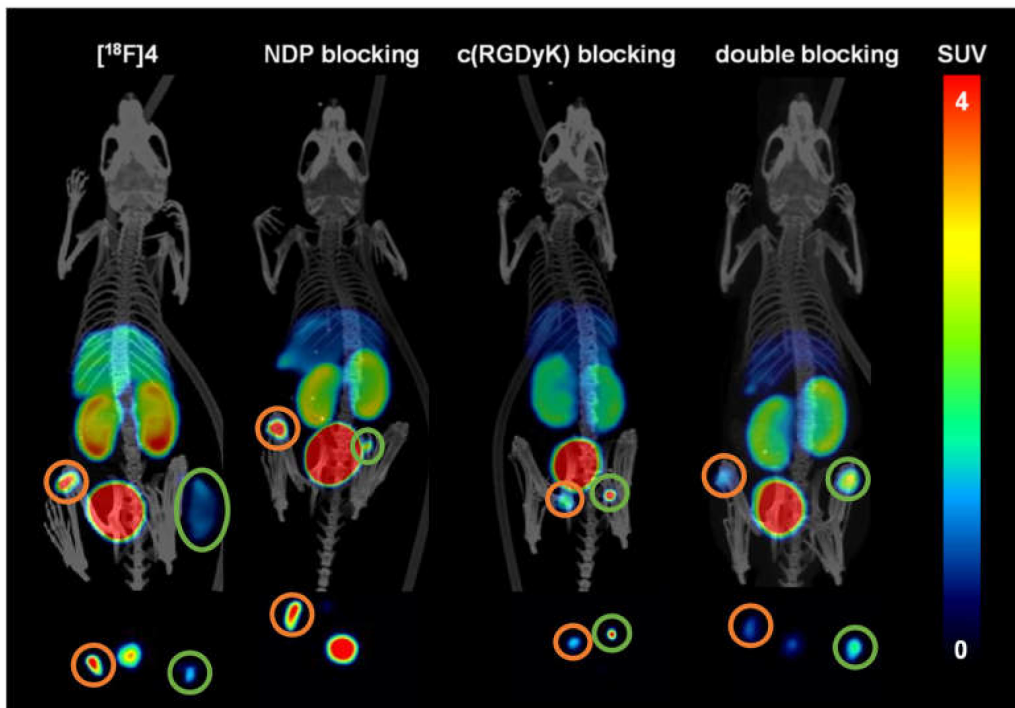
Figure 7. Depiction of the PET/CT images given as MIPs applying [ 18 F] 4 as the radioligand ( n = 3 for each group). From left to right: [ 18 F] 4 without blocking; NDP blocking; c(RGDfK) blocking; blocking using both agents. Shown are MIPs obtained for 50–90 min PI (post-injection). Upper row: coronal slices; bottom row: transaxial slices at tumor level. Circled in orange: U87MG tumors; circled in green: B16F10 tumors. In the transaxial sections, it was not always possible to depict both tumors as some were out of plane.